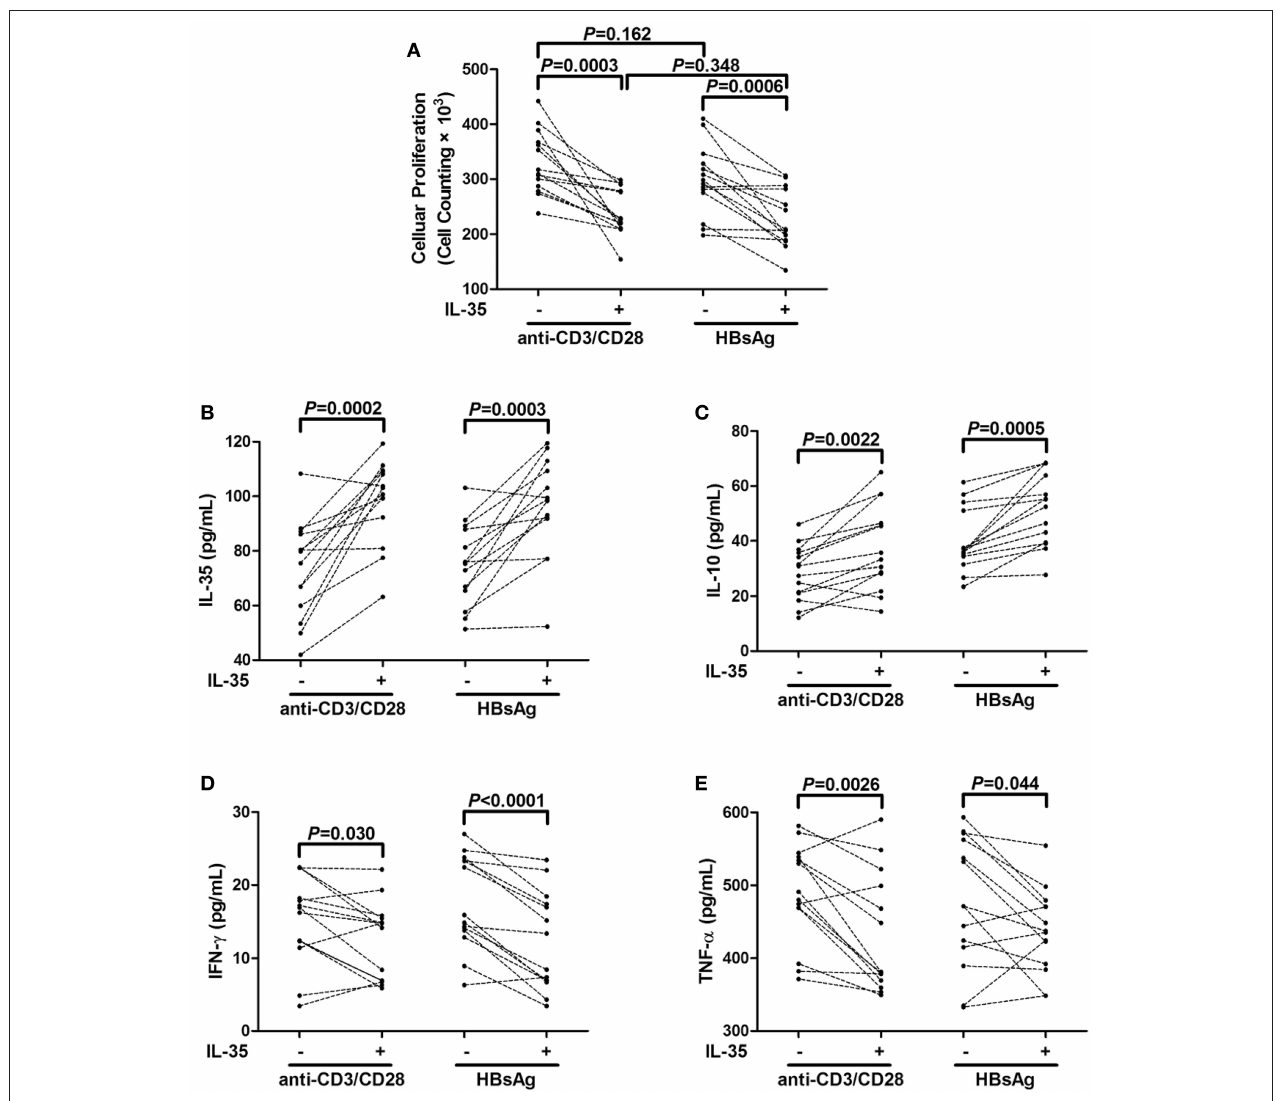
FIGURE 4 | Interleukin (IL)-35 stimulation enhanced suppressive function of CD4 + CD25 + CD127 dim / − regulatory T cells (Tregs) from patients with chronic hepatitis B (CHB, n = 14). Purified CD4 + CD25 + CD127 dim / − Tregs and autologous CD4 + CD25 − T cells were co-cultured at the ratio of 1: 4 in the presence or absence of IL-35 with either anti-CD3/CD28 or recombinant hepatitis B surface antigen (HBsAg) stimulation. (A) Cellular proliferation was measured by cell counting kit-8. Levels of cytokines in the supernatants of co-cultured system was also measured. (B) IL-35 concentration was measured by enzyme-linked imunosorbent assay. Levels of IL-10 (C) , interferon- γ (IFN- γ ) (D) , and tumor necrosis factor- α (TNF- α ) (E) were measured by Human Proinflammation 7-Plex Base Kit using SECTOR Imager. The individual level for each subject is shown. Significances were calculated using paired t